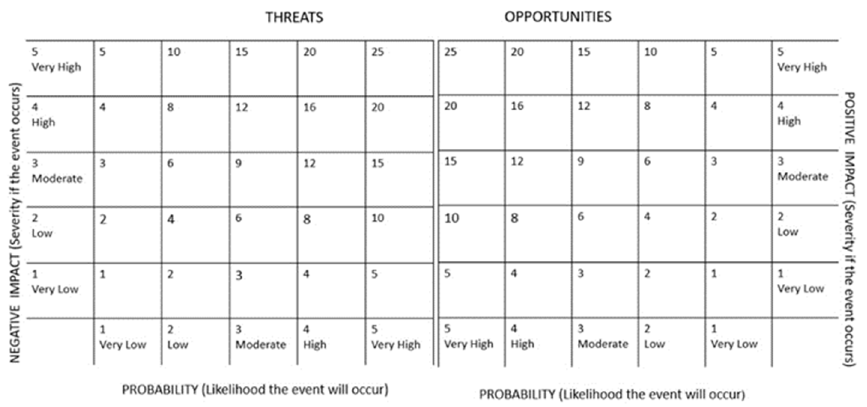
Figure 4. Framework for risk management in the improvement of stimulating social entrepreneur ‐ ship environment in Croatia. Source: Authors.